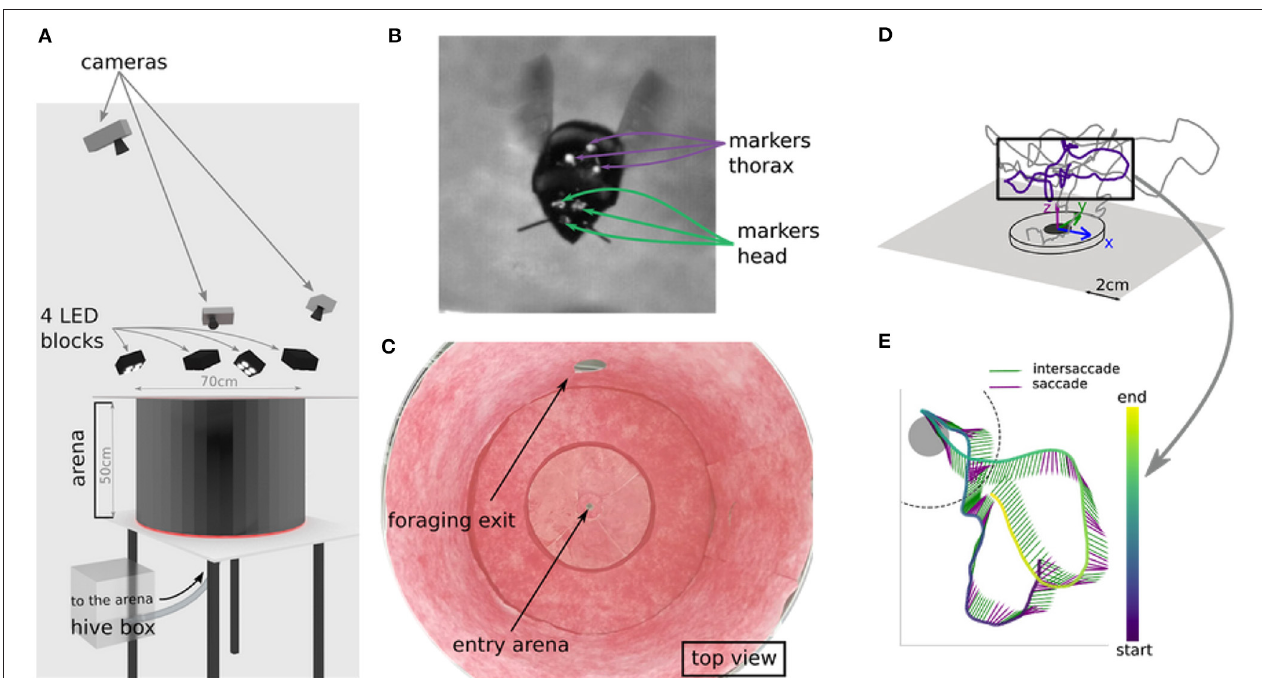
FIGURE 1 | Experimental setup and example flight. (A) Virtual setup of the arena. Bee enters the flight arena through the hole at the bottom, that connects to the hive. (B) Marker positions on head and thorax. (C) Top view of real world arena. (D) Example of a learning flight in 3d space. (E) Temporal structure of a section of a leaning flight as lollipop plot, with each sticks pointing direction indicating thorax orientation and color indicating movement classification (green = intersaccade; purple = saccade).